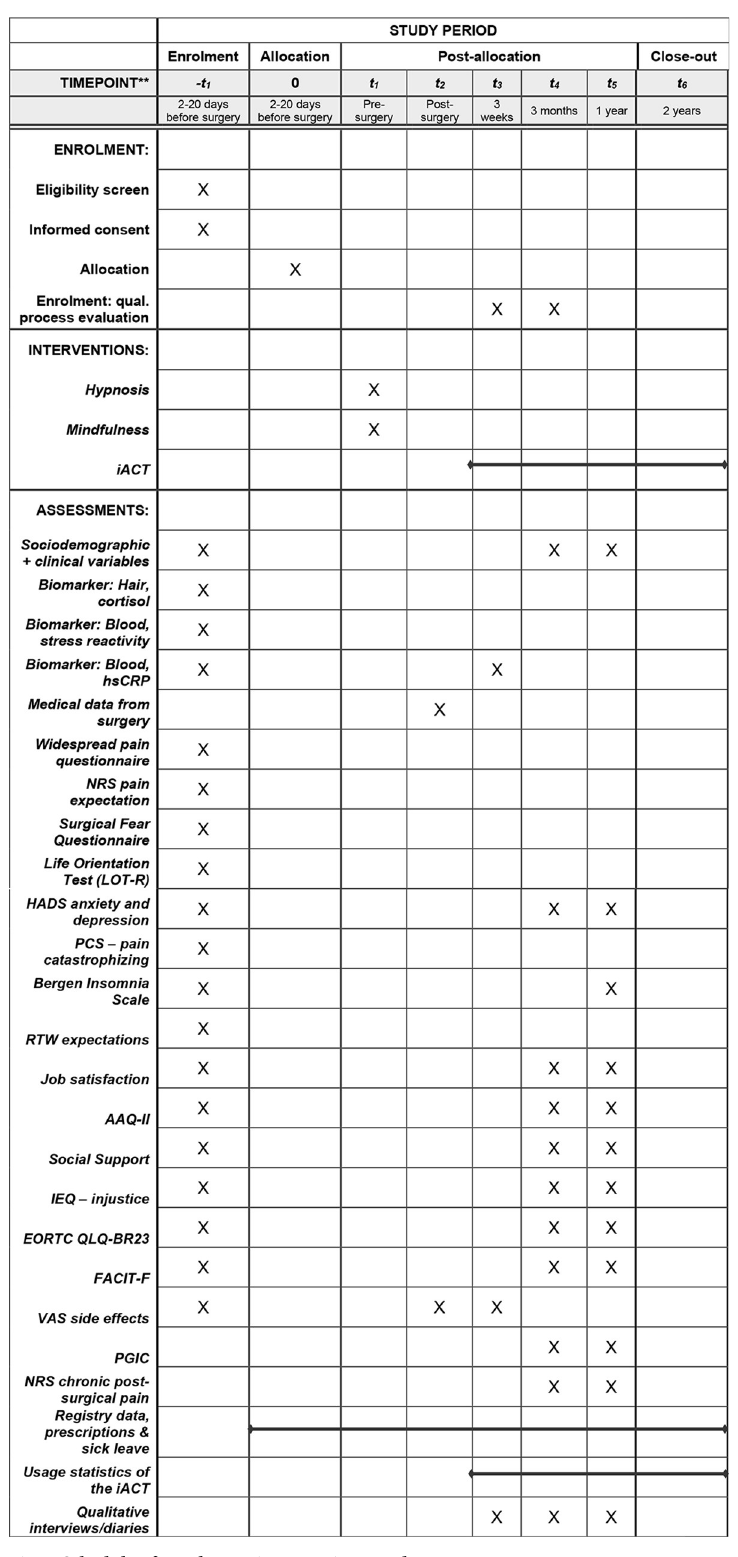
PLOS ONE | https://doi.org/10.1371/journal.pone.0268606 July 8,